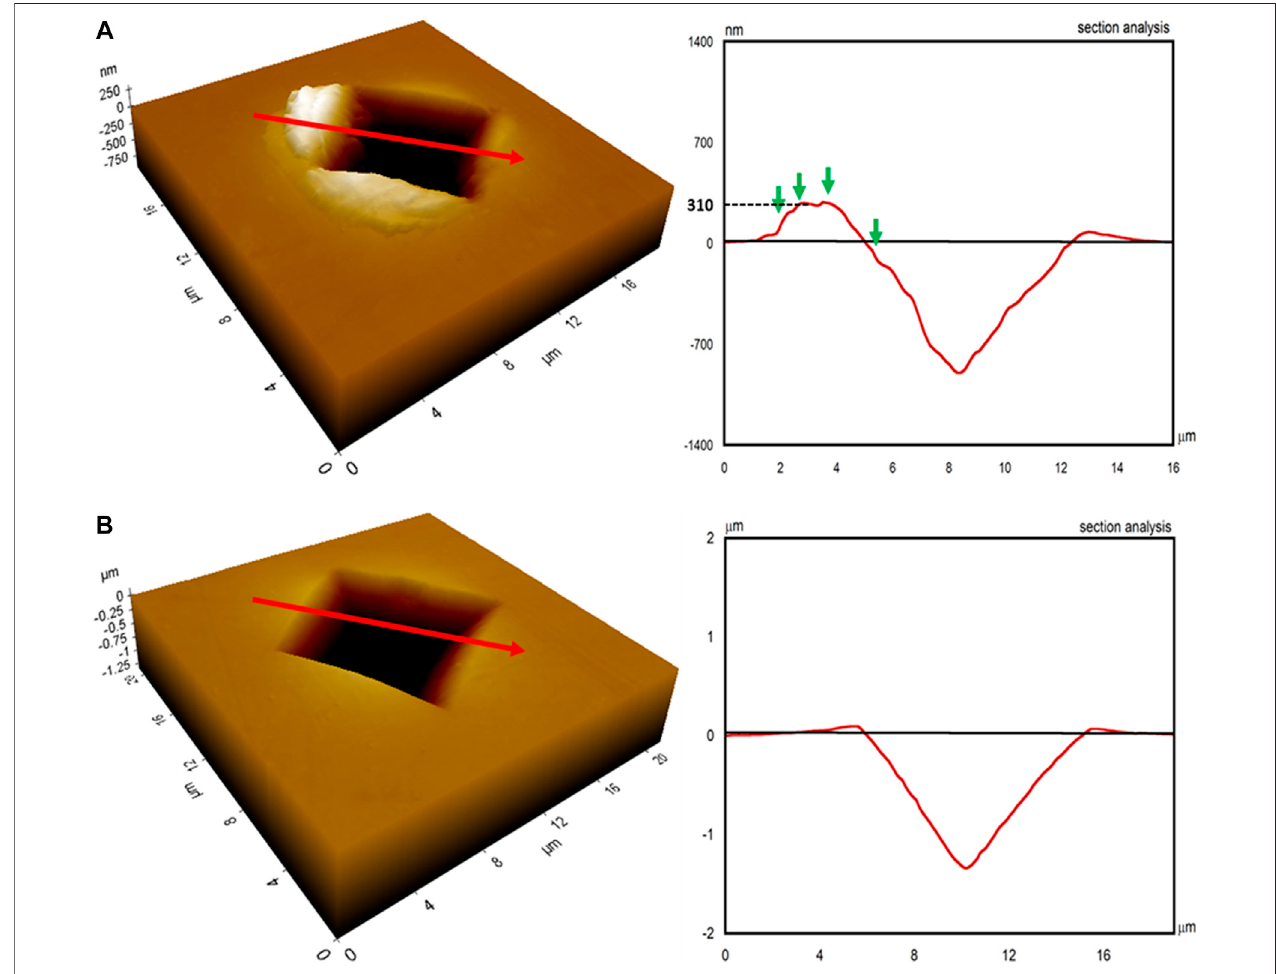
FIGURE6| AFMimagesoftheresidualimprintalongwiththecorrespondinglinescanstakenacrosstheedgeoftheimprintof (A) SRand (B) APNGsobtainedata p of 0.5 N.